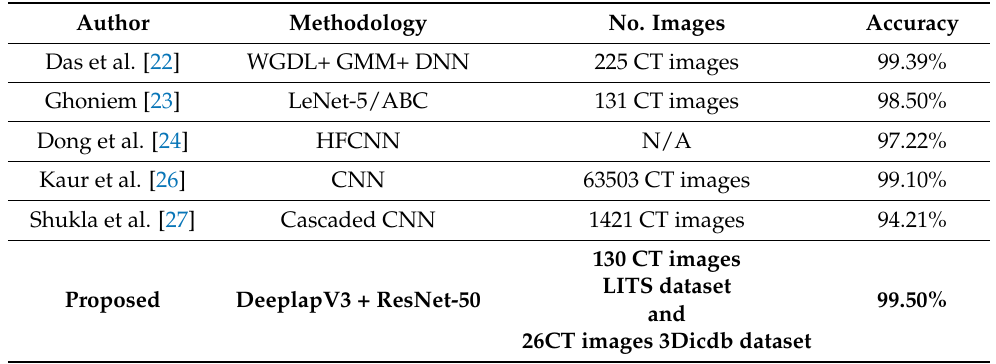
Table 6. Comparison of the performance of our method and those of other previous methods (our results in bold